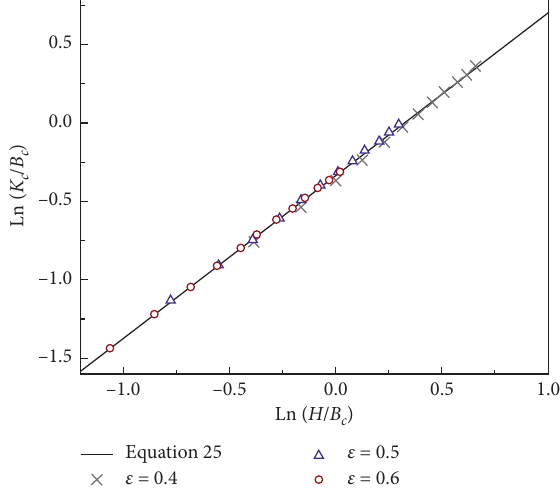
Figure 7: Relationship between Ln( K